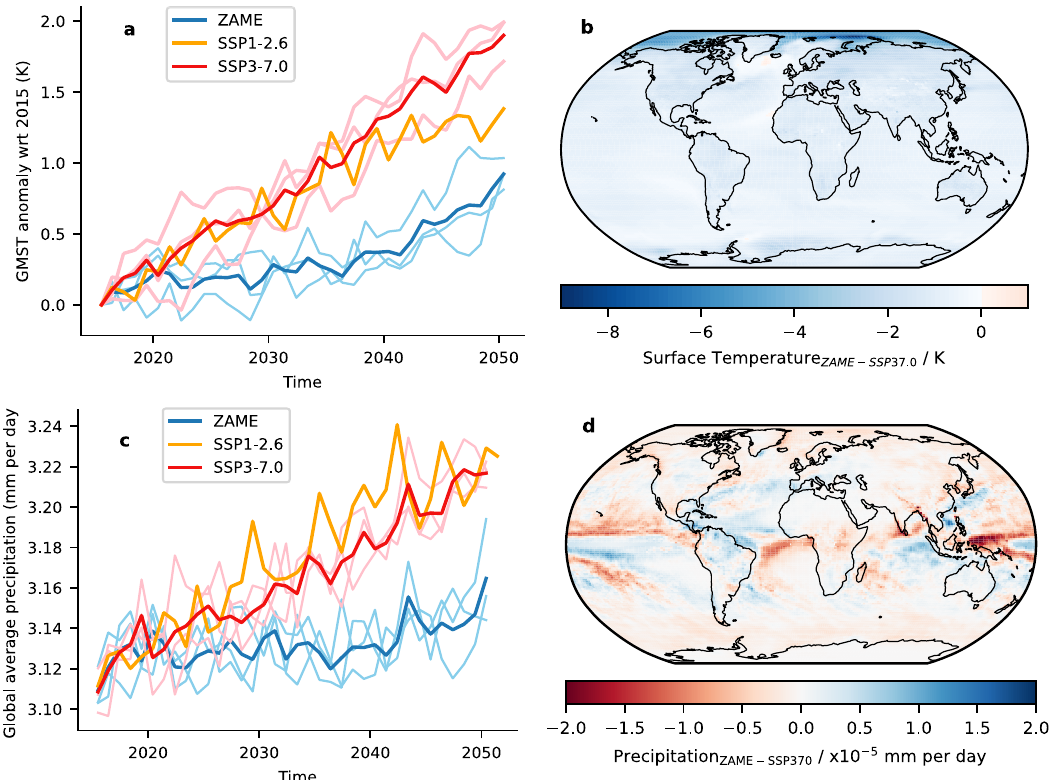
Fig. 3 Physical climate changes associated with zero anthropogenic methane (ZAME), compared to SSP3-7.0 and SSP1-2.6. ZAME is shown in blue, SSP3-7.0 in red and SSP1-2.6 in orange. The fainter coloured lines show the three individual ensemble members and the darker line shows the ensemble mean, for SSP3-7.0 and ZAME. a Global mean surface temperature (GMST) anomaly with respect to 2015 values, for 2015 – 2050. b Global surface temperature difference for 2040 – 2050: ZAME - SSP3-7.0. c Global mean precipitation for 2015 – 2050. d 2040 – 2050 decadal average precipitation in ZAME compared to SSP3-7.0. Red areas correspond to where there is less precipitation in ZAME than